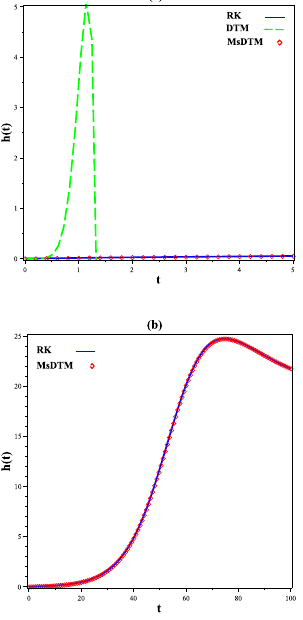
Figure 3: The density of the humans infected with mutant avian influenza with r 0 = 1.06 and R 0 ≈ 7.1